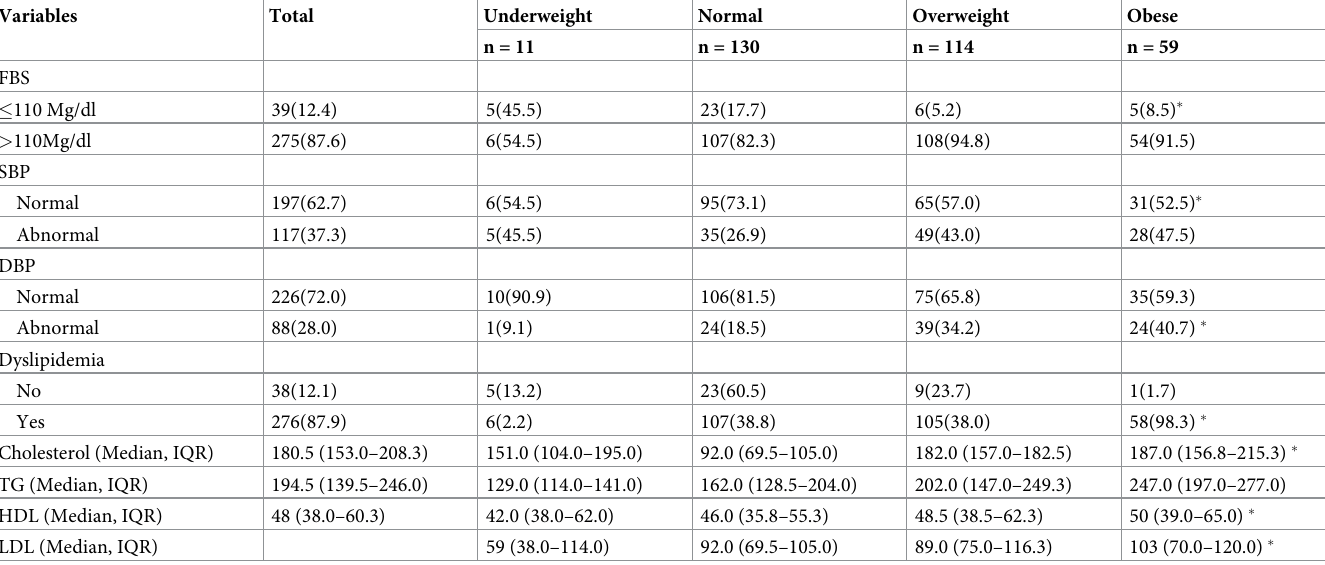
Table 2. FBS, blood pressure, and lipid profiles across the four different bands of BMI in patients with T2DM at HUCSH and YGH from Oct 16 to. Dec. 21, 2018.